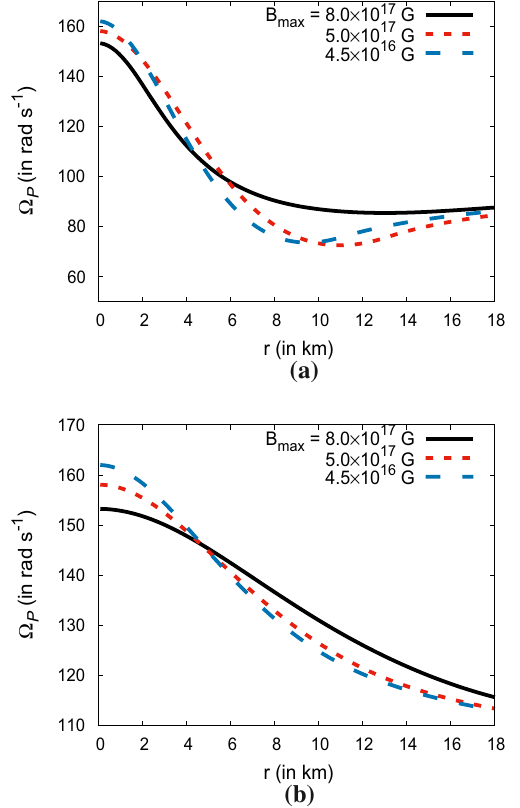
Fig. 21 We have plotted the effect of a toroidal magnetic field on Ω P along the equatorial plane ( a ) and along the polar plane ( b ). The black solid curve, the red short dashed curve and the blue dashed curve are for central magnetic field of 8 . 0 × 10 17 G , 5 . 0 × 10 17 G , 4 . 5 × 10 16 G respectively. Ω is taken to be 100 rad s − 1 . The central energy density of the NS is taken to be 1 . 0 × 10 15 gcm −